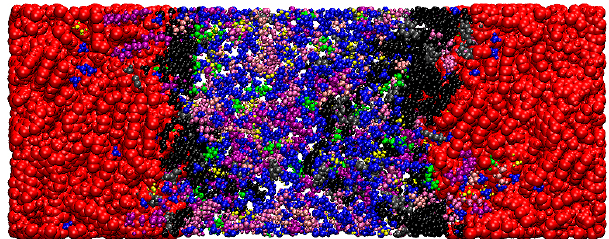
Figure 1. Molecular model of the kerogen slits constructed with a kerogen matrix and multicomponent shale oil. Molecular colours: red, kerogen; black, asphaltene; grey, methylbenzene; purple, n-dodecane; mauve, n-octane; pink, n-butane; green, propane; yellow, ethane; blue, methane.